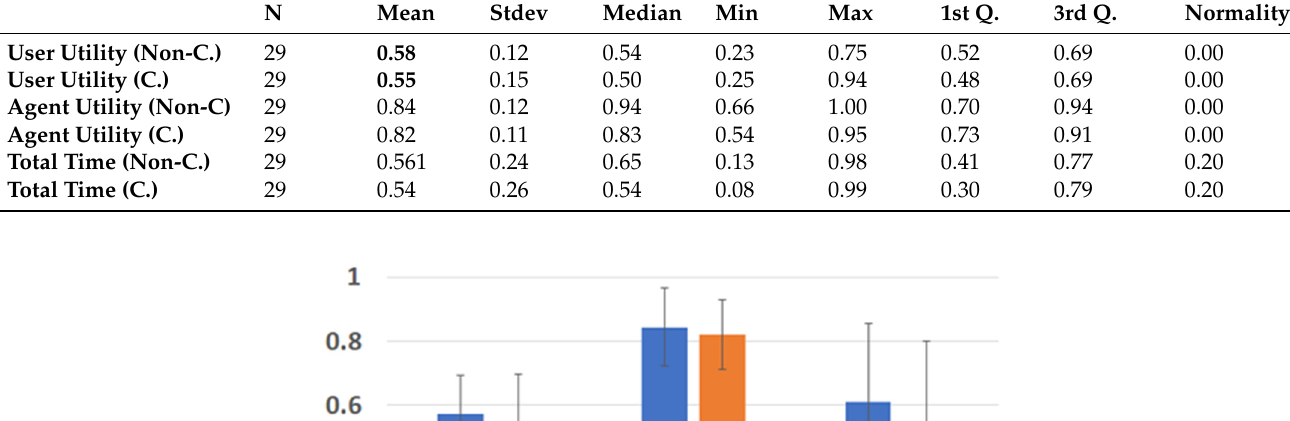
Figure 9. Mean with Error Bars of Negotiation Performance Metrics (participants with positive feel- ings).